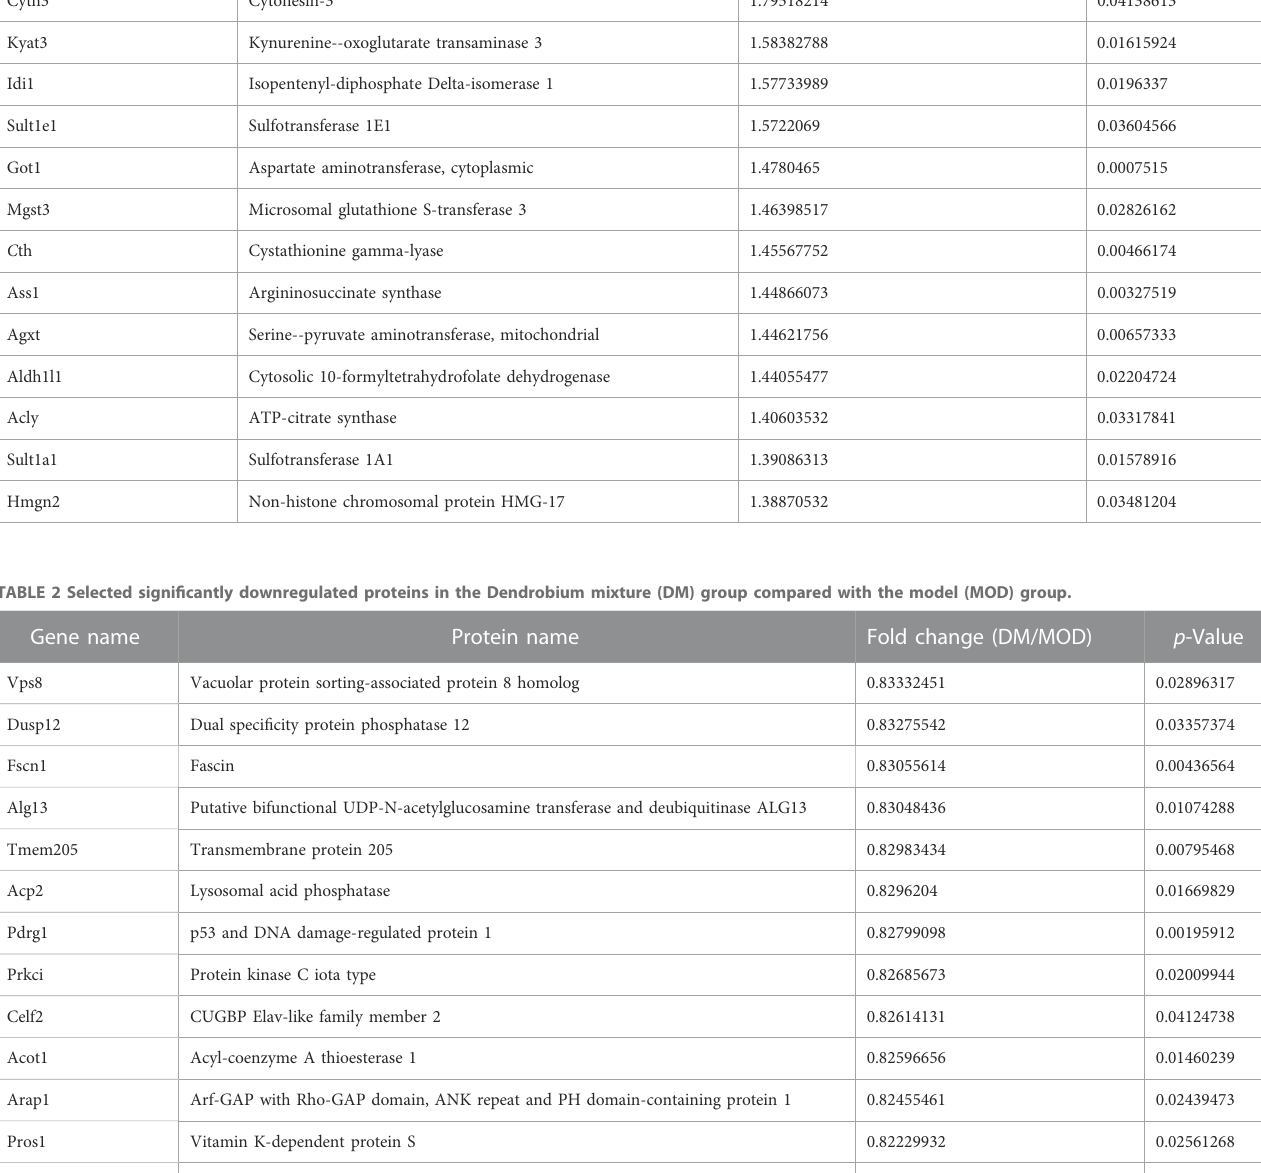
The top 15 differentially signi fi cant expressed proteins (DSEPs) (up and downregulated) are listed in Tables 1, 2. Dimethylaniline